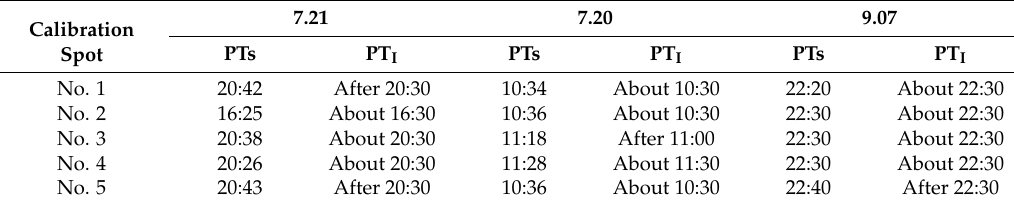
Table 6. Comparison between PT S and PT I of typical runoff processes.